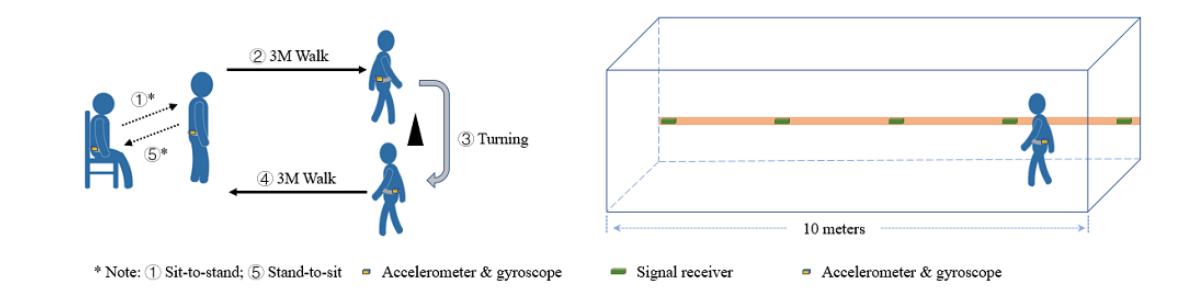
Figure 2. Illustrations of (left) the 3-meter timed up and go test and (right) the 10-meter straight walking